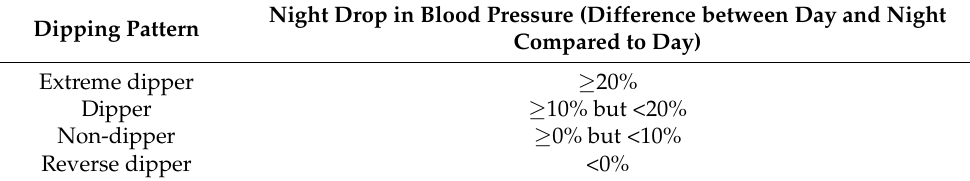
Table 1. Nocturnal blood pressure dipping patterns according to the European Society of Hypertension [2]. Night Drop in Blood Pressure (Difference between Day and Dipping Pattern